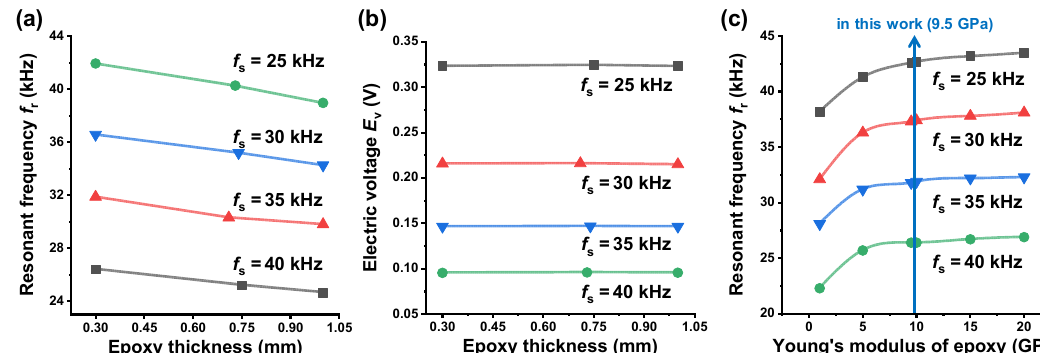
Figure 3. ( a ) Variation of resonant frequency f r with epoxy thickness; ( b ) Variation of electric voltage E v with epoxy thickness; ( c ) Dependence of Young’s modulus of epoxy on resonant frequency f r .